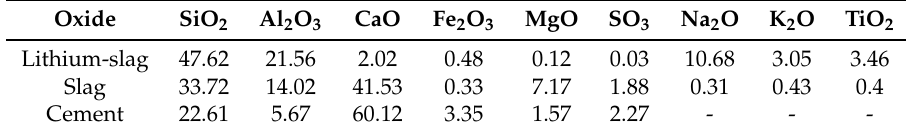
Table 2. The chemical composition of slag, lithium-slag and cement (%).